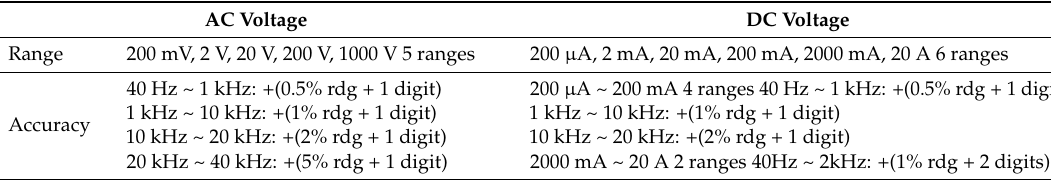
Table 1. Specifications of GW Instek GDM-8135 Digital Multimeter.